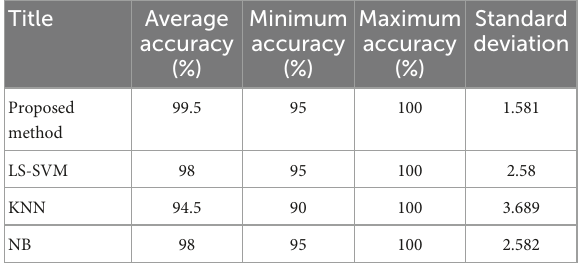
TABLE 3 Summary of prediction results of each tested